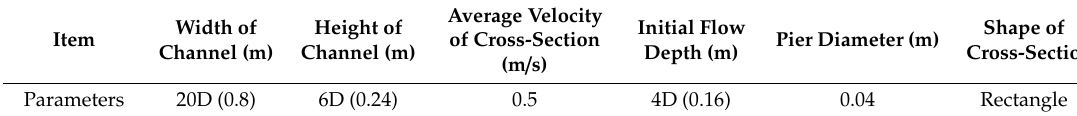
Table 2. Parameters of the model.